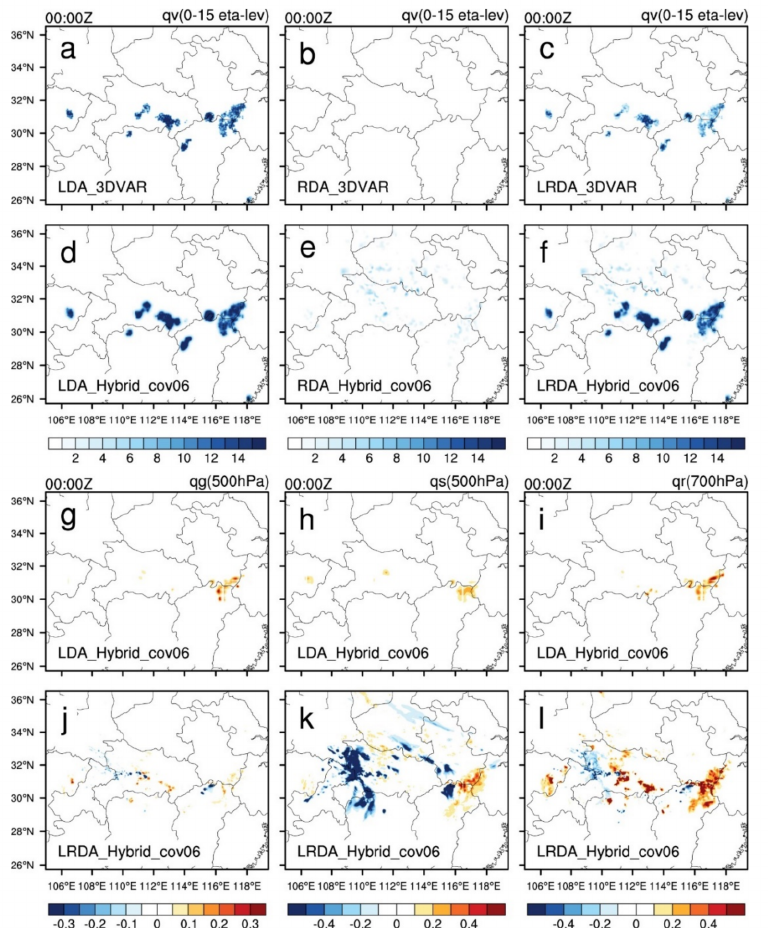
Figure 5. The single-analysis increments of water vapor mixing ratio ( q v ) from 0 eta level to 15 eta level ( a – f ) were summed; graupel mixing ratio ( q g ) at 500 hPa ( g , j ), snow mixing ratio ( q s ) at 500 hPa ( h , k ), and rain mixing ratio ( q r ) at 700 hPa ( i , l ) at 0000 UTC 30 June 2018 (analysis time). ( a ) Lightning data assimilation by 3DVAR. ( d , g – i ) Lightning data assimilation by hybrid 3DEnVAR. ( b , e ) Radar data assimilation by 3DVAR and hybrid 3DEnVAR. ( c ) The combined lightning and radar data assimilation by 3DVAR, and ( f , j – l ) uses hybrid